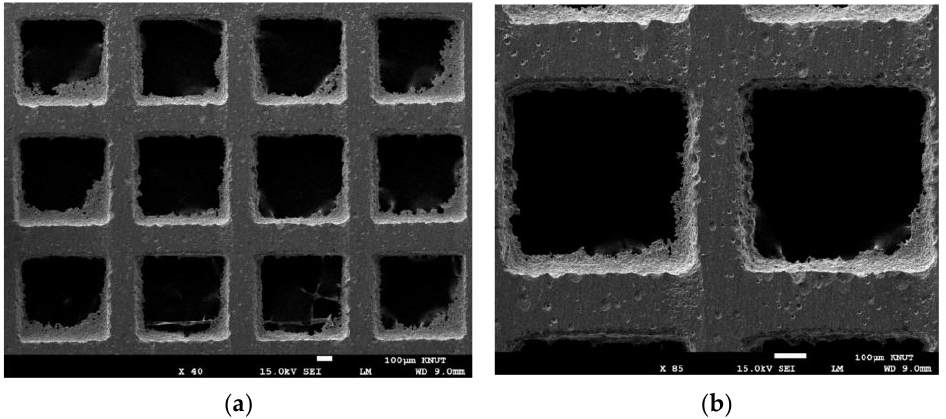
Figure 11. Penetrating square pattern through DEE process: ( a ) penetrating square pattern; ( b ) magnified view of penetrating square.